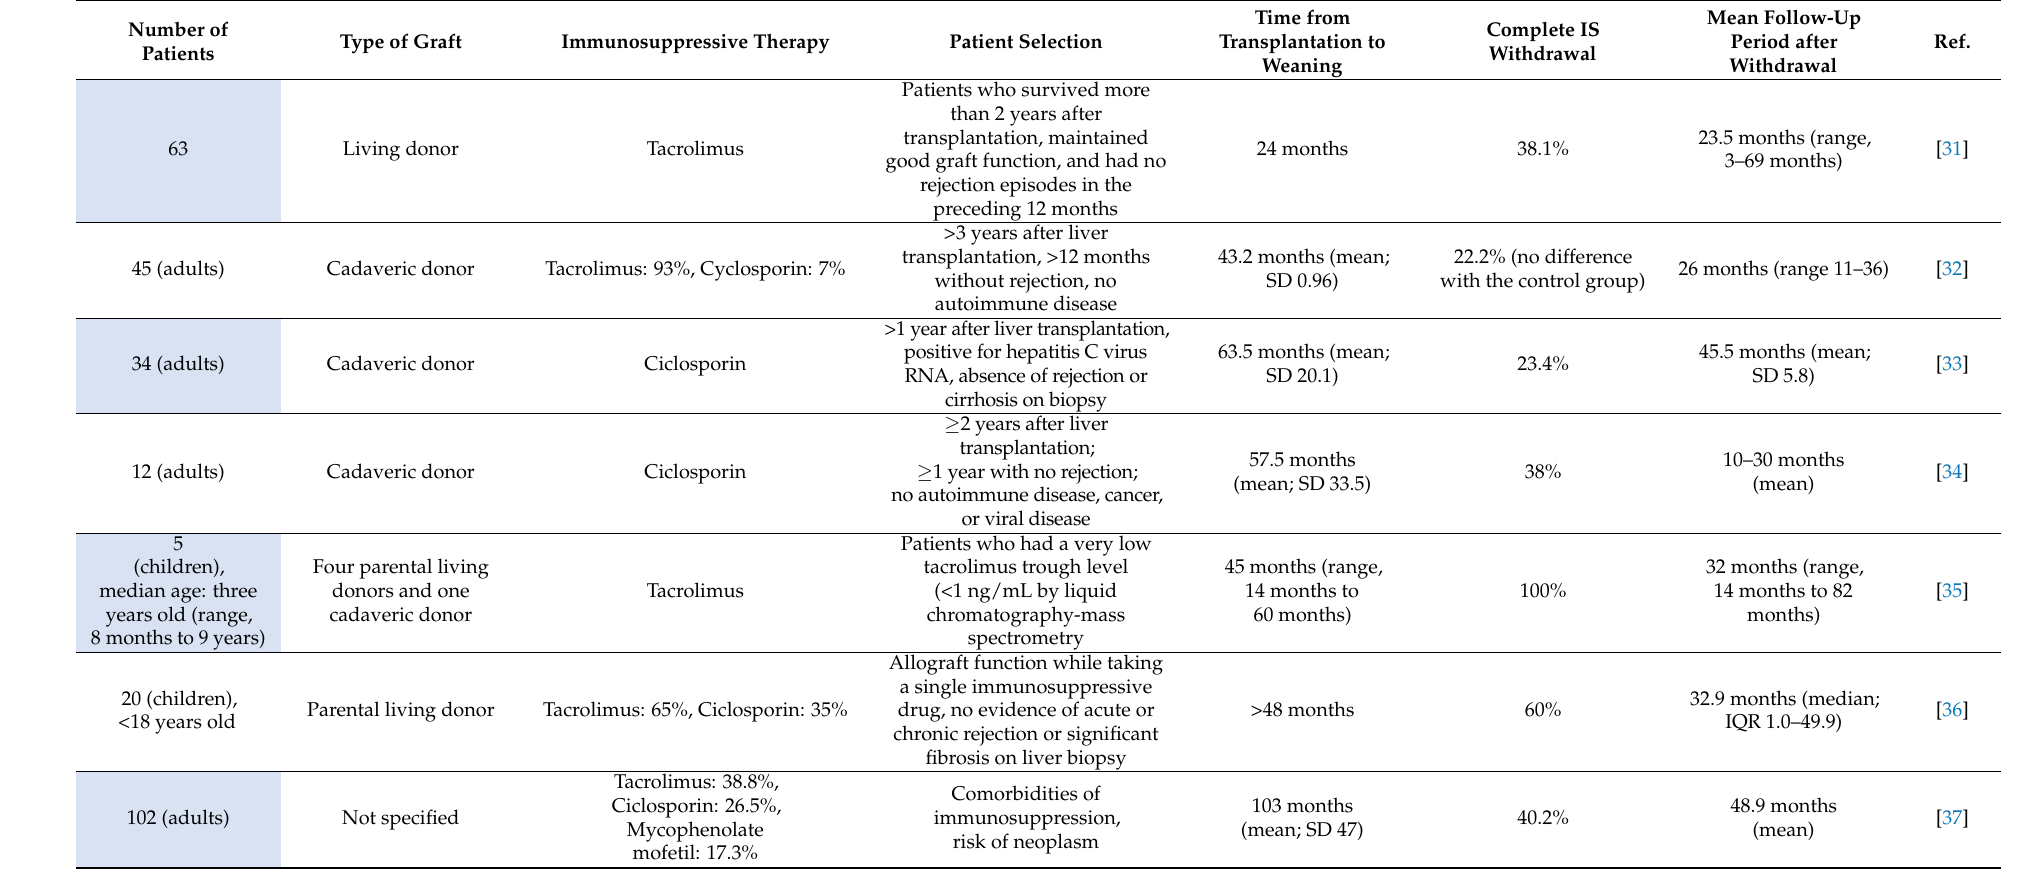
Table 1. Clinical experiences of immunological tolerance in liver transplant